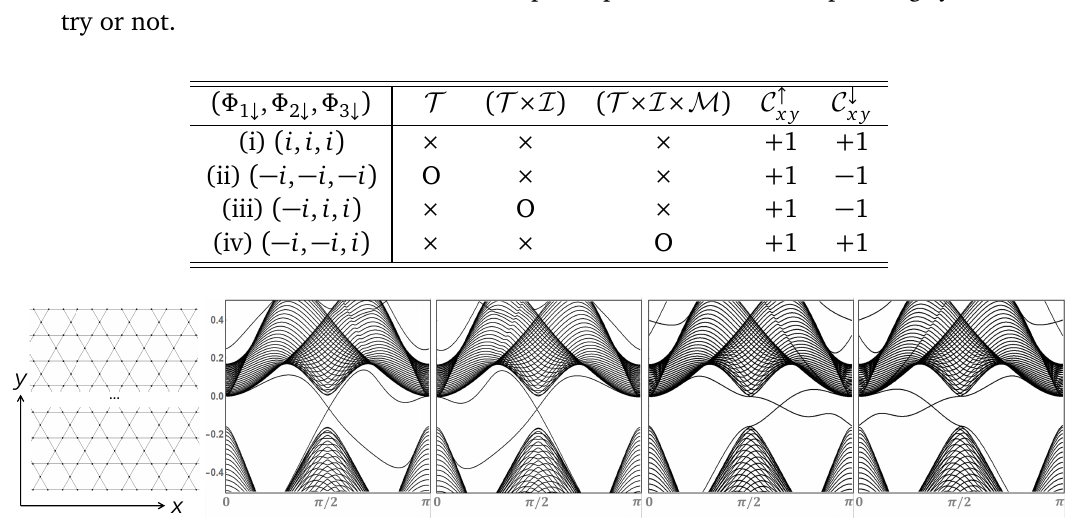
Figure 3: Left panel: The kagome lattice with an open boundary condition in the y -direction. The edge boundaries are cut on the upper and lower bound- aries of the extended 2 × 2 unit cell. The down-spin 3 Q -iCDW edge spectra as